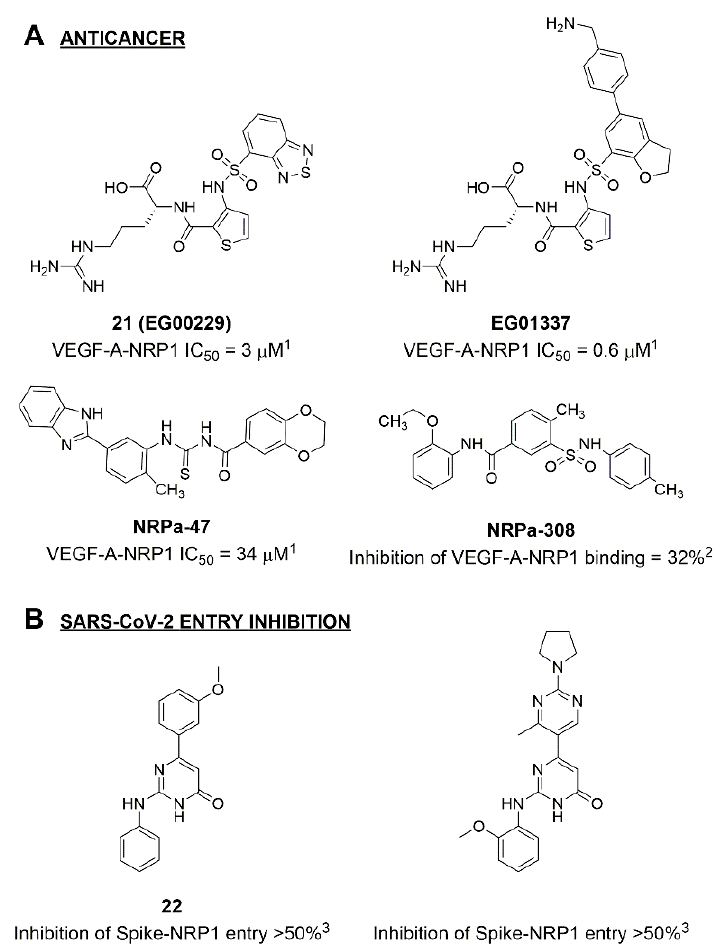
Figure 2. ( A ) Some of the best characterized antagonists of the VEGF-A binding to the NRP1 b1 domain. ( B ) Small-molecules identified as potential antagonists of the spike induced SARS-CoV-2 entry. 1 Cell-free bt-VEGF-A165 binding assay, measuring inhibition of VEGF binding to the b1 domain on NRP1 [35,38,39]. 2 Cell-free bt-VEGF-A165 binding assay measuring inhibition of